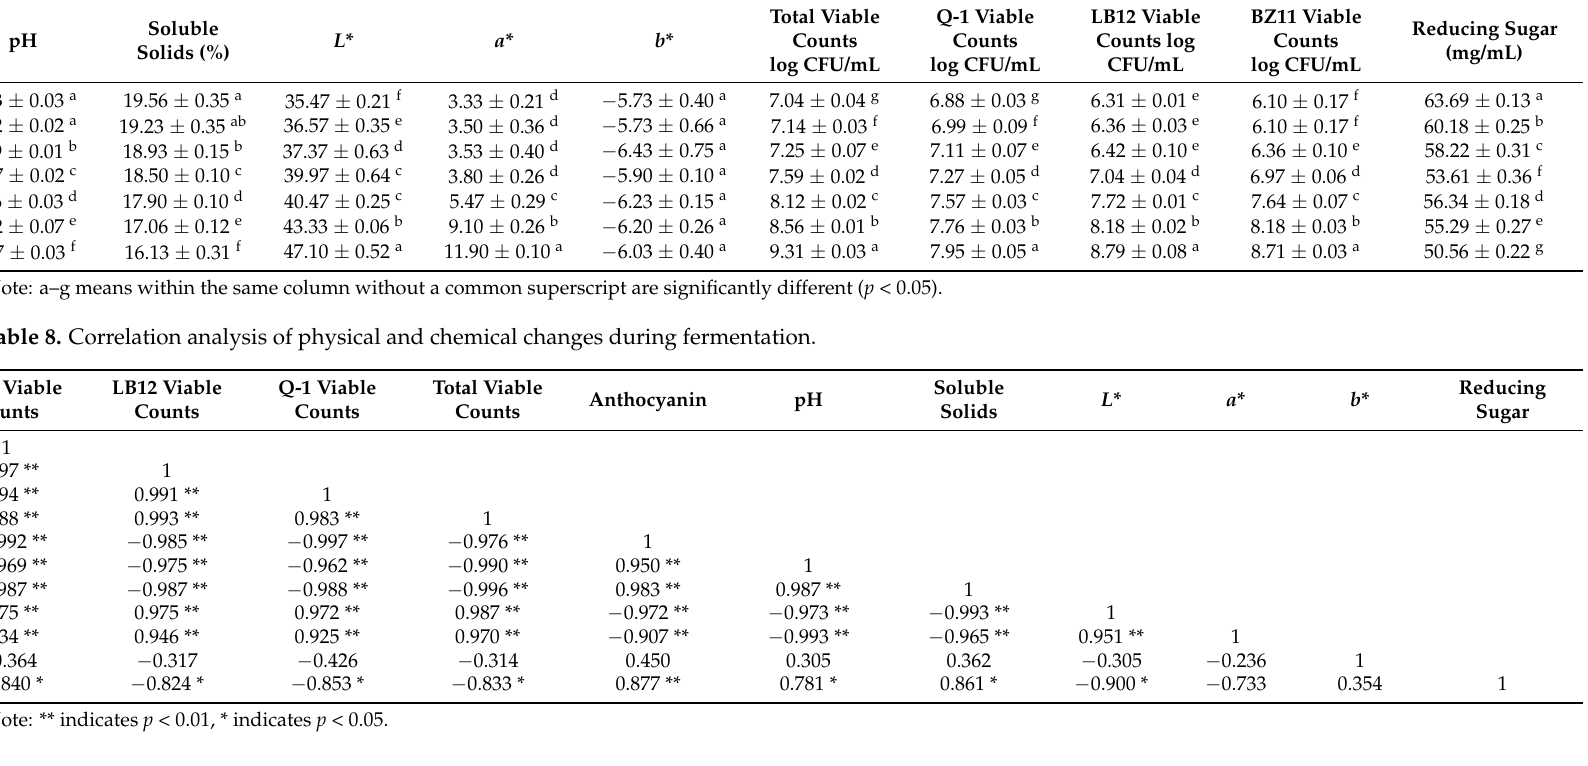
Table 7. Physical and chemical changes during fermentation.